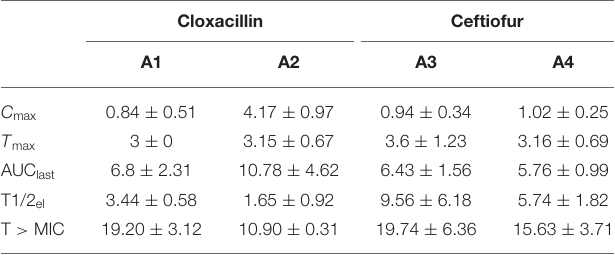
TABLE 5 | Mean ± SD ( n = 20 per groups A1, A2, and A3 and n = 19 per group A4) for the pharmacokinetic parameters and therapeutic efficacy indices for cloxacillin (CLX) and ceftiofur (CFT) detected in cow milk for each formulation containing Aloe vera combined with cloxacillin or ceftiofur, after a single dose.